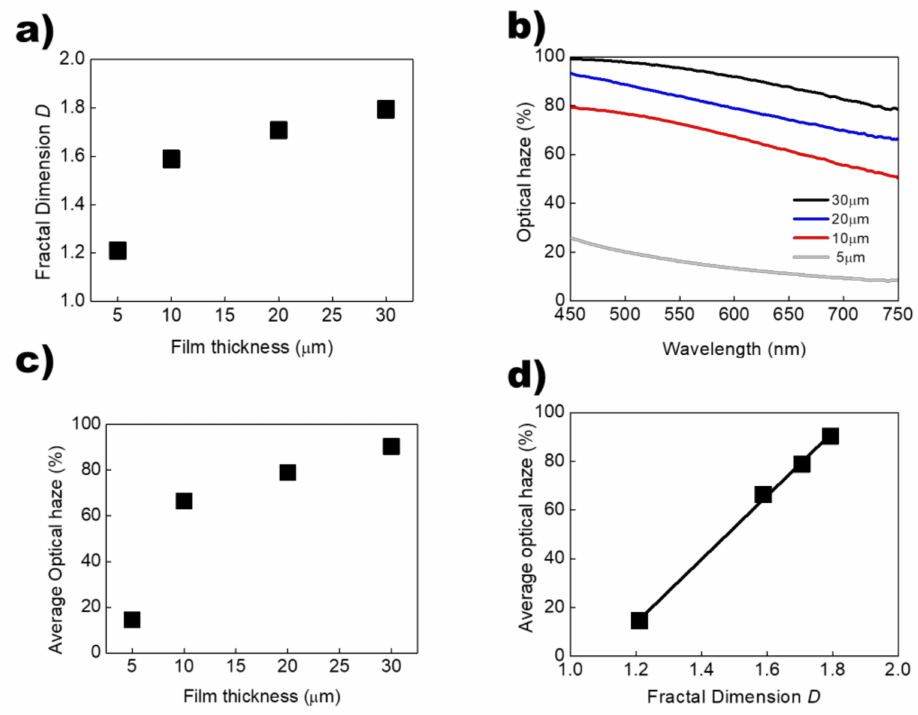
Figure 4. ( a ) D of the LC droplet surrounded by polymer networks as a function of film thickness. ( b ) Optical haze profiles of the four MSLC films prepared with different thicknesses. ( c ) Average optical haze over the wavelength range of 450 ≤ λ ≤ 800 nm as a function of film thickness. ( d ) Plot of average optical haze versus the D of the LC droplets in the prepared MSLC films with different